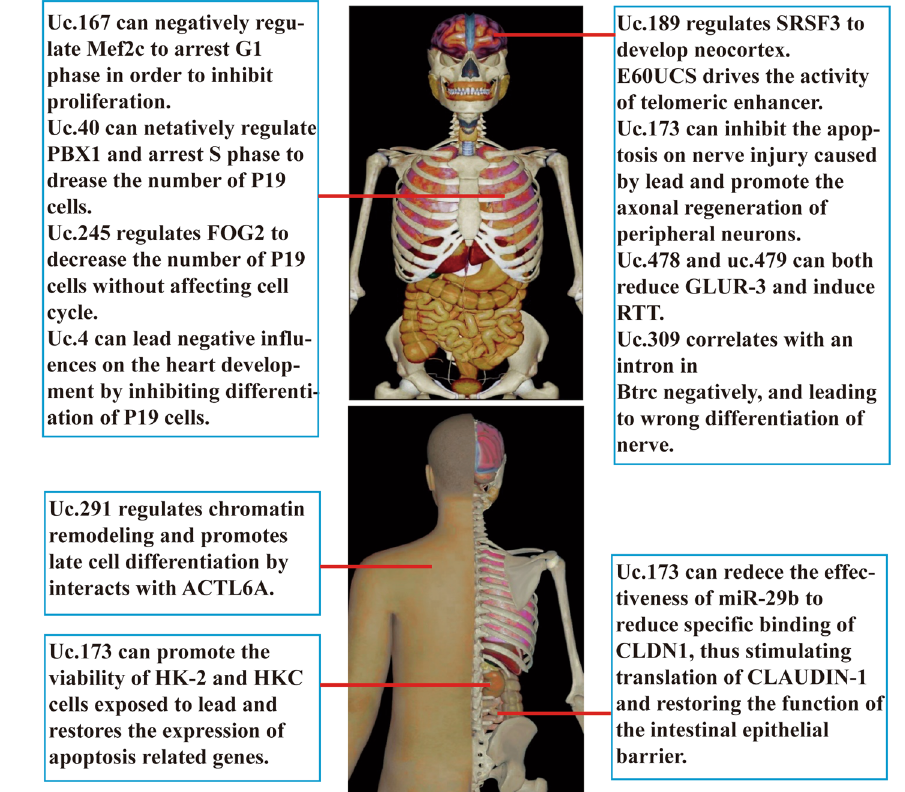
Fig. 1 The roles and poten- tial mechanisms of ucRNAs in physiological activities. Influences of each ucRNA are shown on the normal physi- ological activities of various systems and organs of the human body, mainly including heart, nerves, skin, kidney and intestine. At the same time, this figure also indicates the mechanisms of ucRNA to some